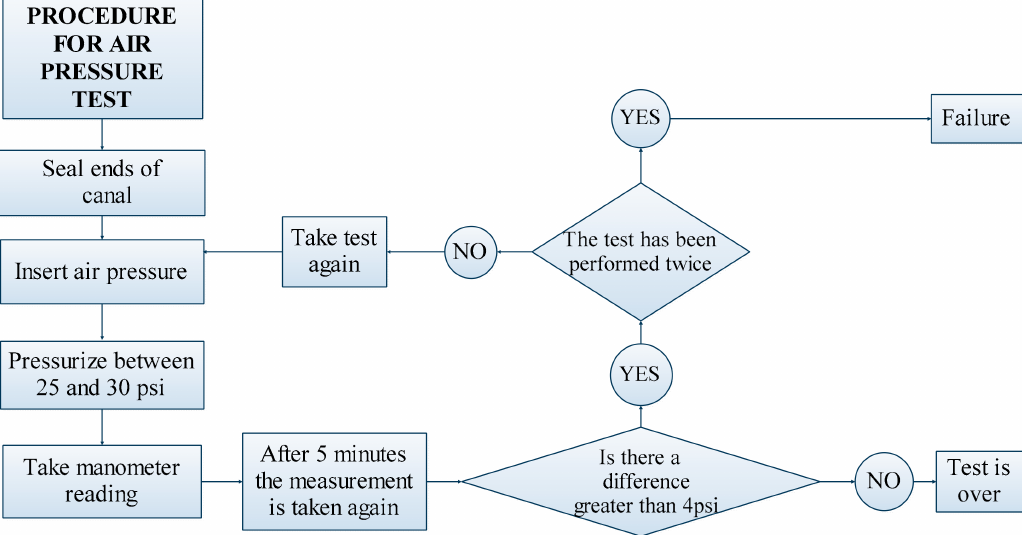
Figure 5. Diagram of the procedure for air pressure